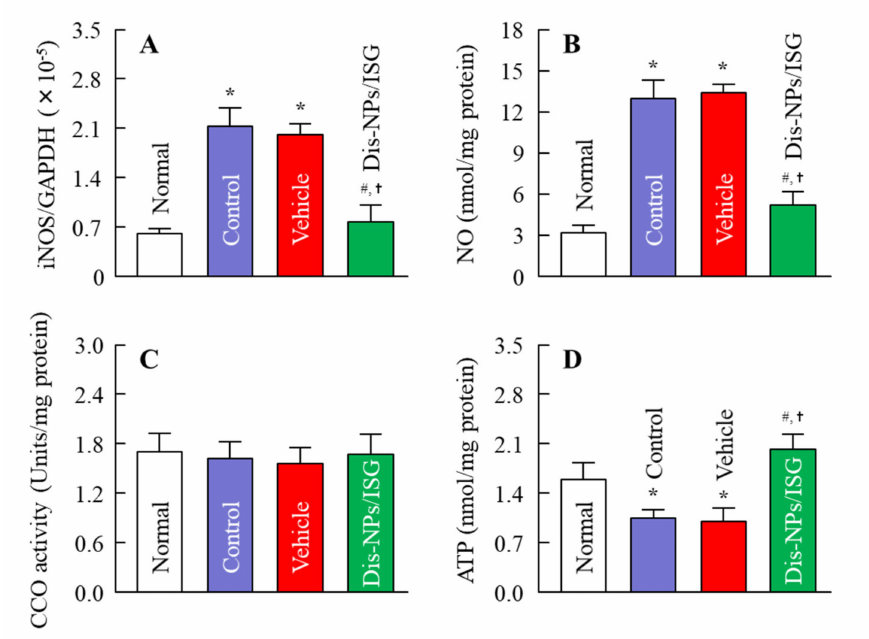
Figure 6. E ff ect of the Dis-NPs / ISG on inducible NO synthase (iNOS) mRNA ( A ), nitric oxide (NO) ( B ), cytochrome c oxidase (CCO) activity ( C ), and ATP levels ( D ) in the retinas of 15-month-old OLETF rats. The Dis-NPs / ISG was repeatedly instilled into the right eye of OLETF rats for 1 month (twice a day, 9:00 a.m. and 7:00 p.m.). Normal, noninstilled normal rat; Control, noninstilled OLETF rat; Vehicle, vehicle-instilled OLETF rat; Dis-NPs / ISG, Dis-NPs / ISG-instilled OLETF rat. n = 6–8. * p < 0.05 vs. normal for each category. # p < 0.05 vs. control for each category. † p < 0.05 vs. vehicle for each category. The repetitive instillation of the Dis-NPs / ISG prevented NO production via iNOS mRNA and attenuated the decrease in ATP levels in the retinas of 15-month-old OLETF